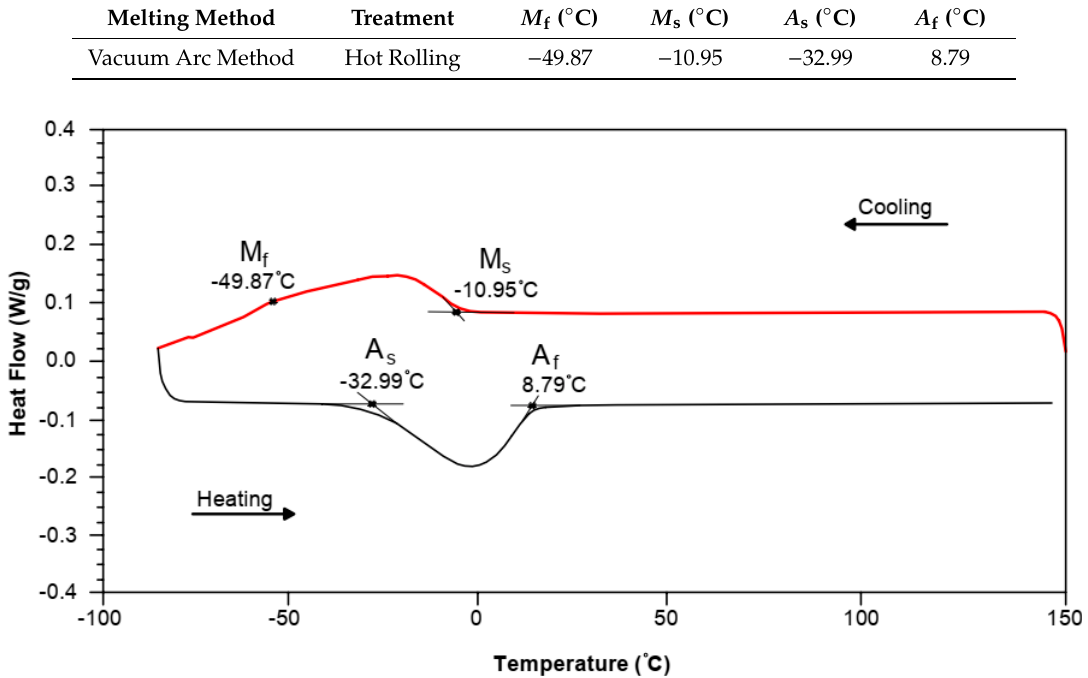
Figure 2. Phase transformation-temperature graph of NiTi SMA.